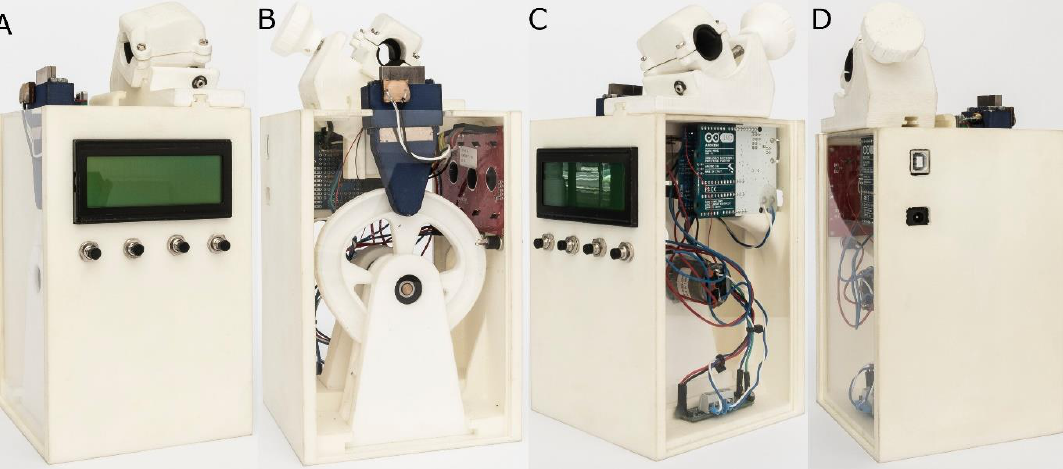
Figure 3. ( A ) Front, ( B ) back, ( C ) right, and ( D ) left surfaces of the dynamic cyclic fatigue device.